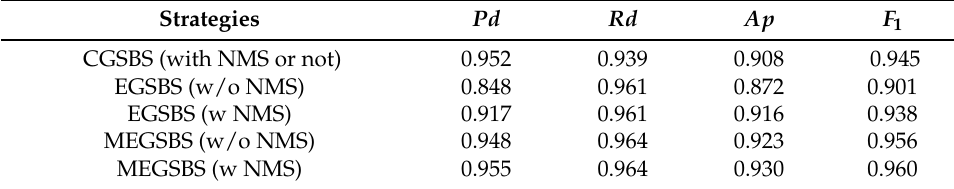
Table 2. Experimental Results of the Different Sample Balancing